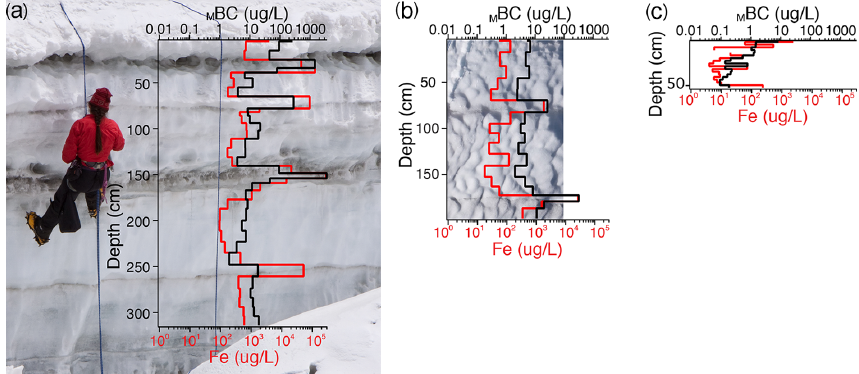
Figure 4. M BC and Fe (used as a dust proxy) concentrations from Mera glacier crevasse profiles and snow pits from (a) Mera La (5400ma.s.l.), (b) below Mera High Camp (5800ma.s.l.), and (c) from a snow pit near the summit of Mera Peak